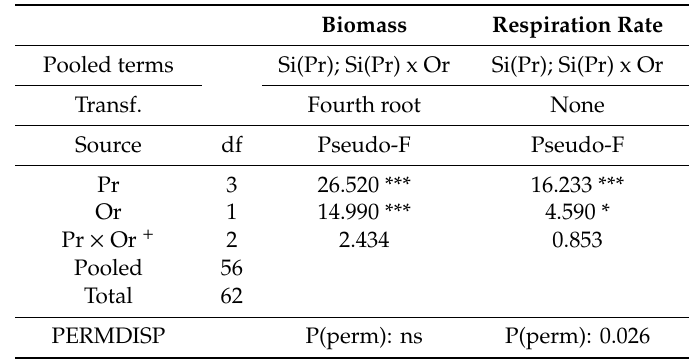
Table 10. Univariate analysis of variance of biomass and respiration rates across “Pressure” levels (Pr), “Origin of biofilm” (Or) and “Sites” (Si(Pr)) after 15 weeks of panel deployment. Analyses are based on Euclidean distances. Pair-wise comparisons were performed when significant di ff erences were found (see Supplementary Materials Table S6).